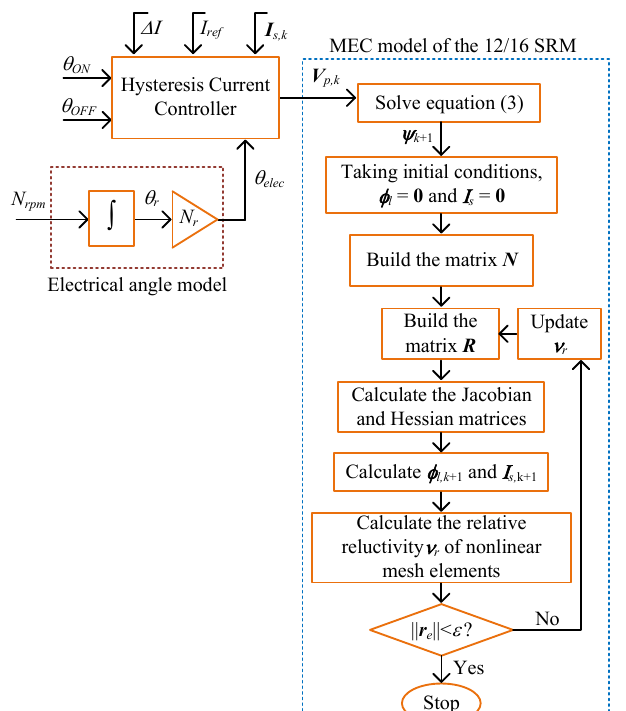
Figure 4. The procedure for implementing the dynamic model, including the magnetic saturation effects and mutual